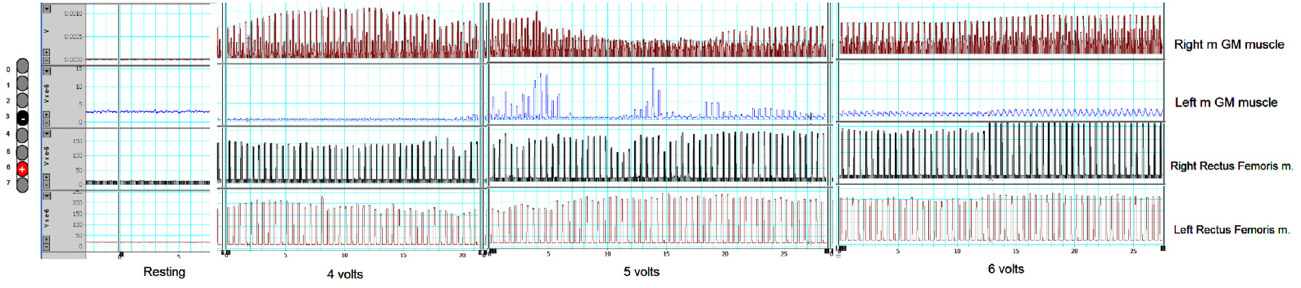
Figure 5. The EMG responses of rectus femoris (RF) m. and medial gastrocnemius (mGM) m. after setting the cathode at − 3 and the anode +6. The unilateral configuration of the right lead appeared to achieve and target bilateral firing of the knee extensors and was later on used for full standing using a standard walker. Table 2. We used two distinct muscle group segmental approaches to identify the optimum stimu- lation configurations (cathodes and anodes) that led to the activation of bilateral RF followed by GM muscle groups using a midline single lead. All pulses were delivered at 2 Hz and 210 µs.